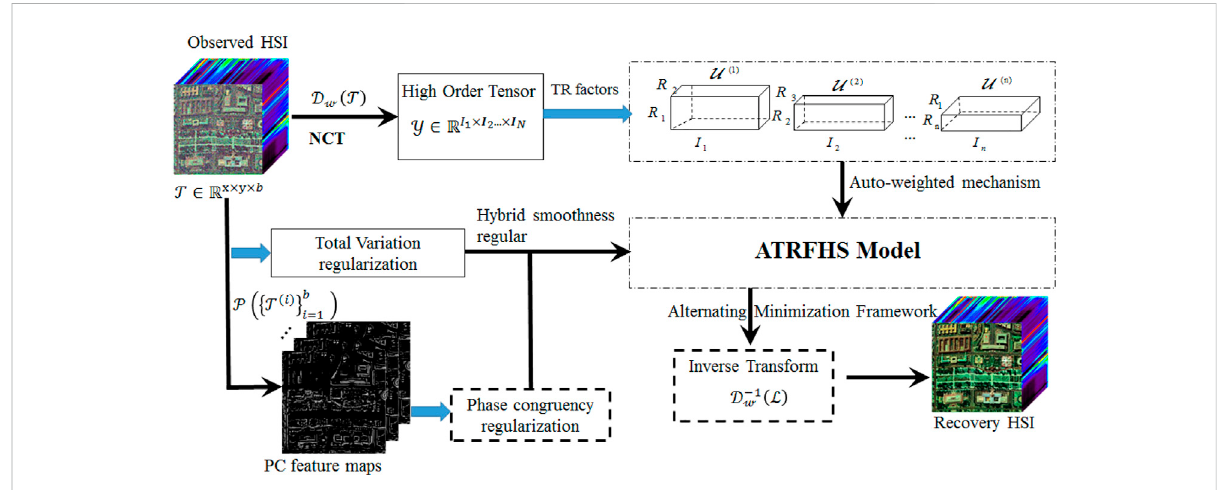
FIGURE 4 Illustration of the proposed ATRFHS for HSI Denoising.